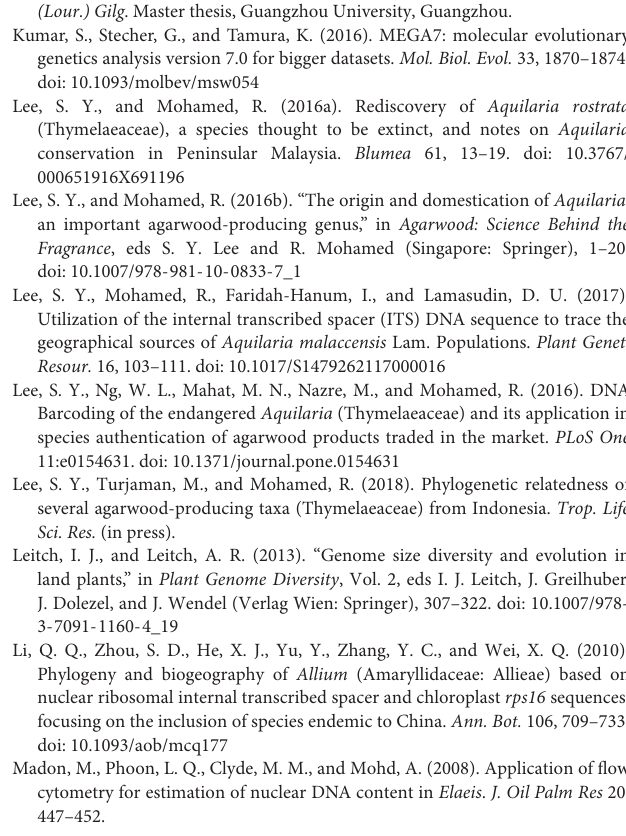
cytometry for estimation of nuclear DNA content in Elaeis . J. Oil Palm Res 20, 447–452.